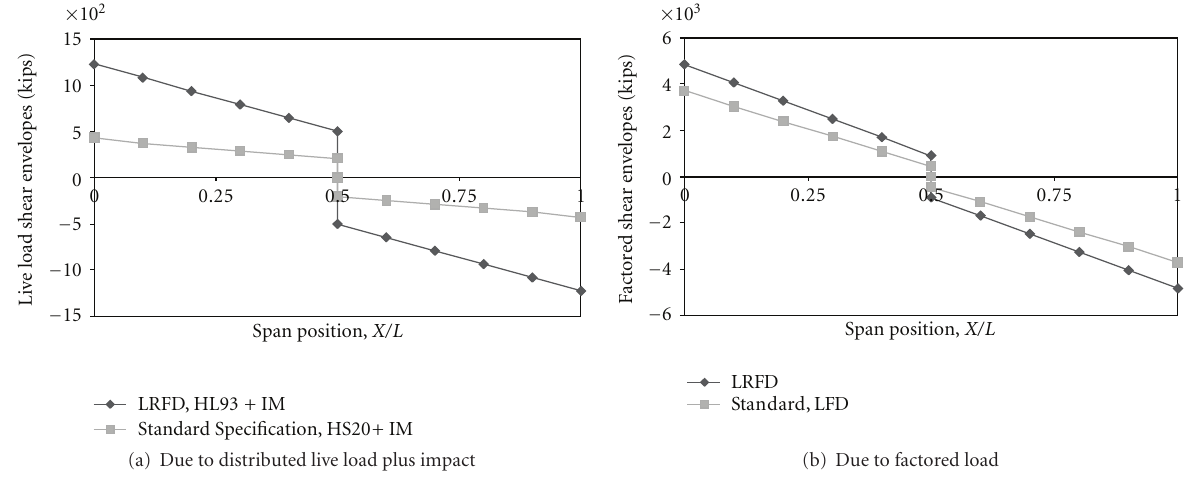
Figure 3: Comparison of shear force envelopes for 180 ft single-span box girder with 8 webs spaced at